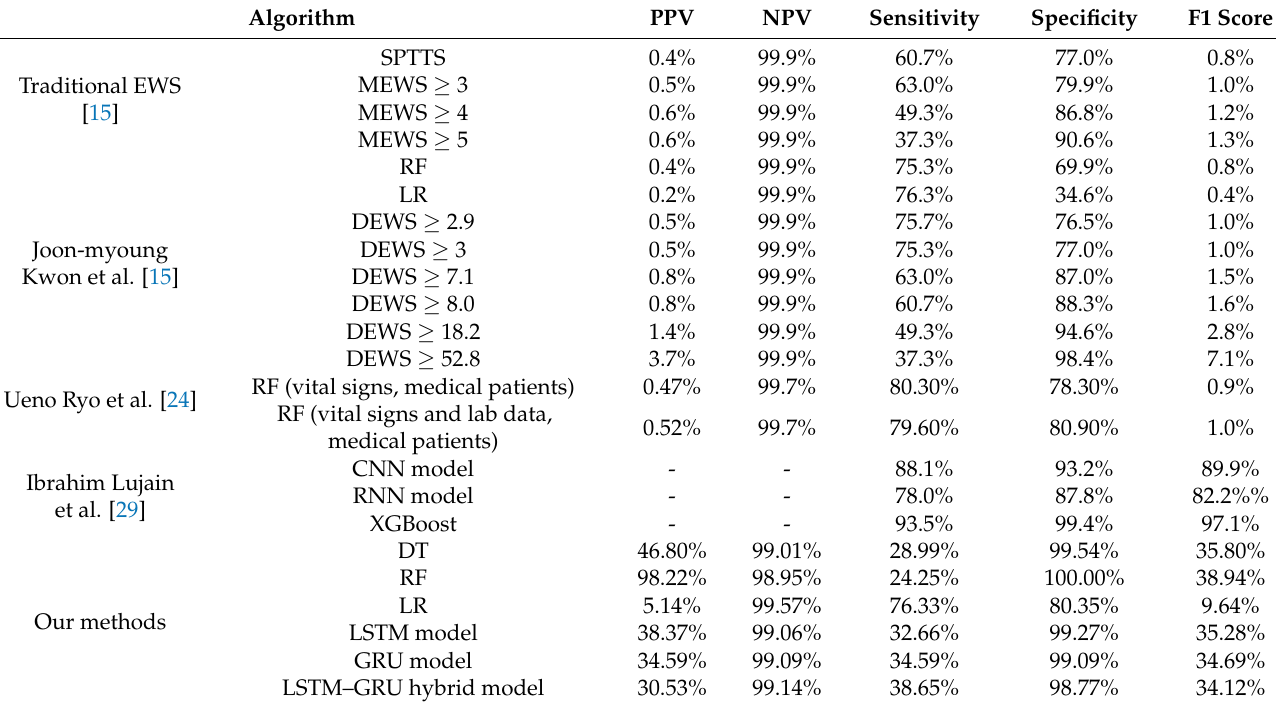
Table 9. Results of EWS and our methods. Our proposed LR had higher PPV and sensitivity than traditional EWS.